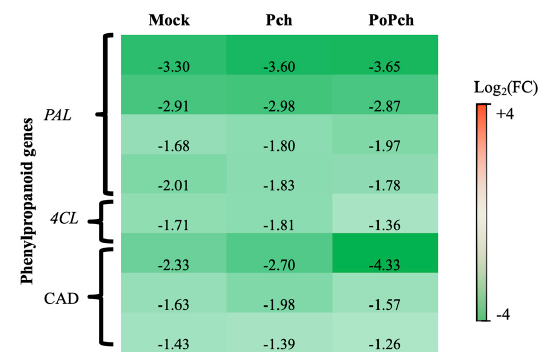
Figure 3. Characteristics of the grapevine transcriptome evolution for genes involved in the phenylpropanoid biosynthesis pathway between 0- and 14-dpi. Expression level values of phenylpropanoid genes ( PAL : phenyl-alanine-ammonia lyase, 4CL : 4-coumarate-CoA ligase and CAD : cinnamyl alcohol dehydrogenase) are given as the fold change on a log 2 basis. The red color means overexpression at 14-dpi and the green color means overexpression at 0-dpi. Mock: mock inoculation; Po: Pythium oligandrum ; Pch: Phaeomoniella chlamydospora ; PoPch: P. oligandrum and P. chlamydospora .